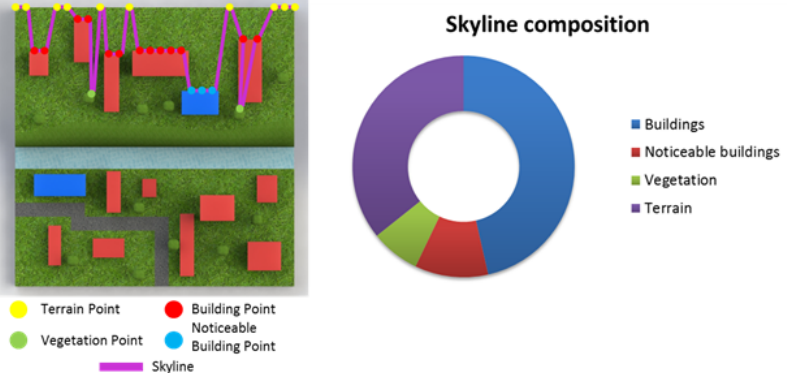
Figure 9. ( Left ): Top view of 3D skyline for a given point or view (purple). ( Right ): Composition of this skyline.